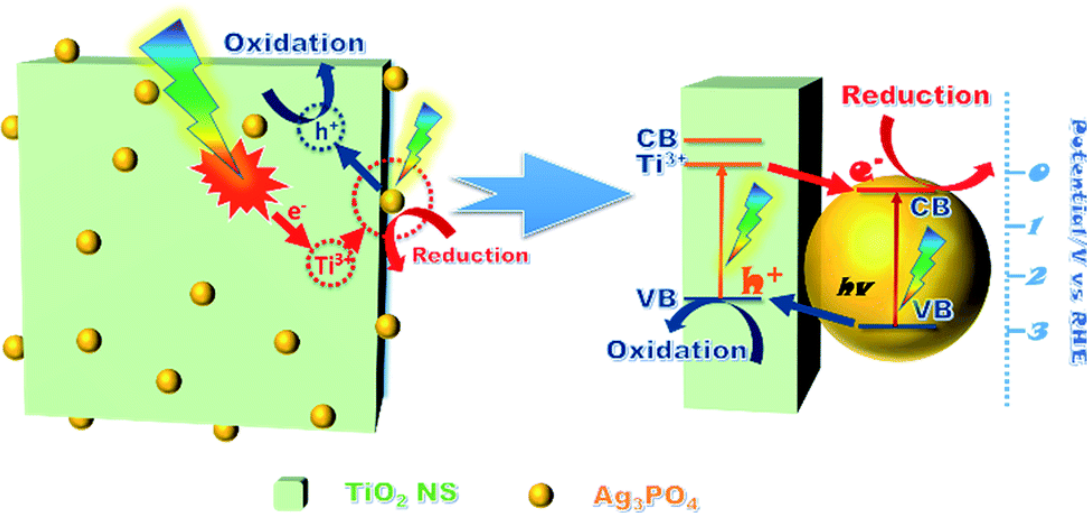
Figure 12. Schematic of the Ag 3 PO 4 QDs–TiO 2 nano spheres (NS) composite and its energy diagram and photocatalytic mechanism under visible light irradiation. Reproduced from [145]. Copyright (2016), The Royal Society of Chemistry.